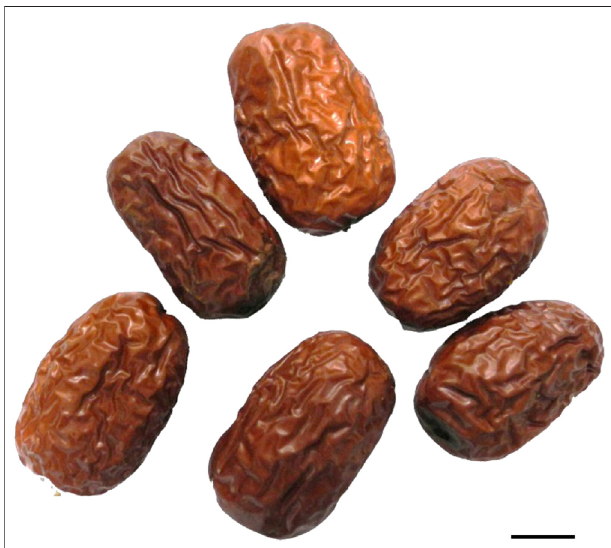
FIGURE 1 | The photo of Z. jujuba fruits. The photo of dried jujubes collected from Xinjiang province, one of major production regions of jujubes in China. Bar: 1